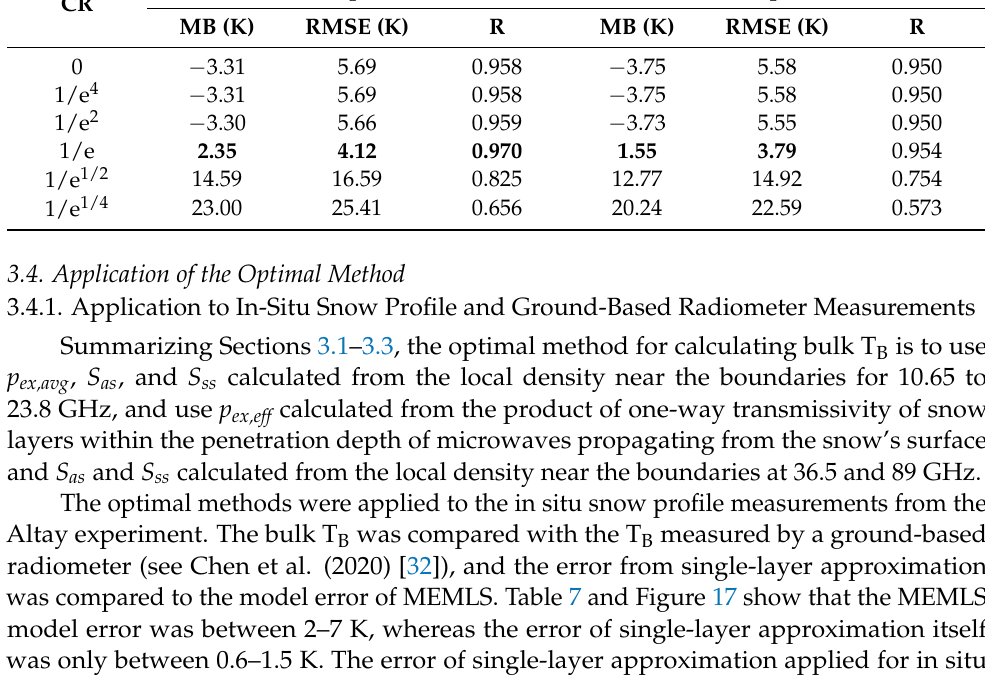
Table 6. Statistics for mean bias (MB), RMSE and correlation coefficient (R) with different penetration depth thresholds (CR) at 36.5 GHz and a 55° incidence angle. The values in bold represent the highest accuracy among different CR thresh- olds.